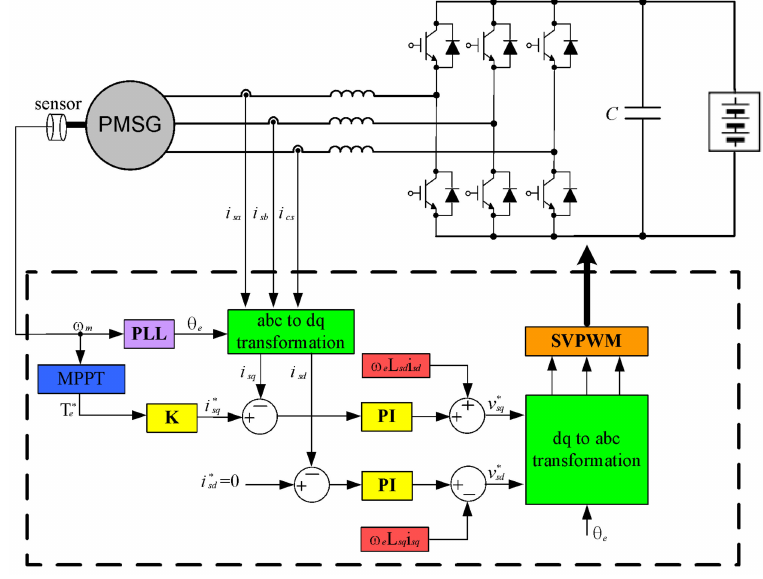
Figure 5. Block diagram of PWM converter for generator